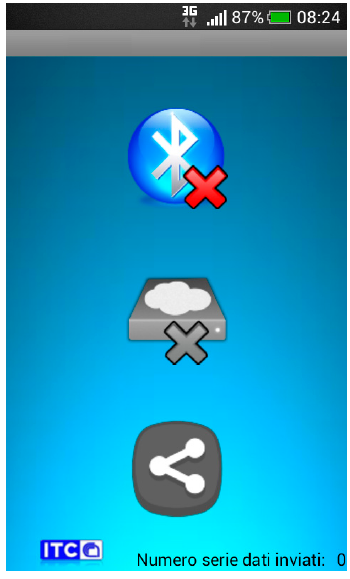
Figure 2. Mobile device app for Android OS.